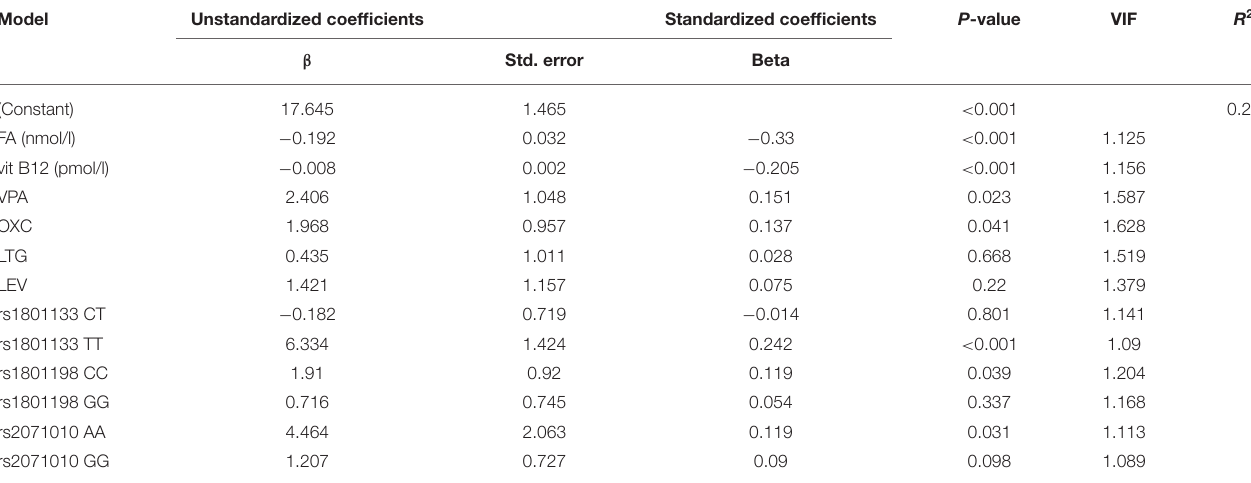
TABLE 3 | Effects of AEDs, SNPs and vitamins on Hcy levels in patients with epilepsy. Model